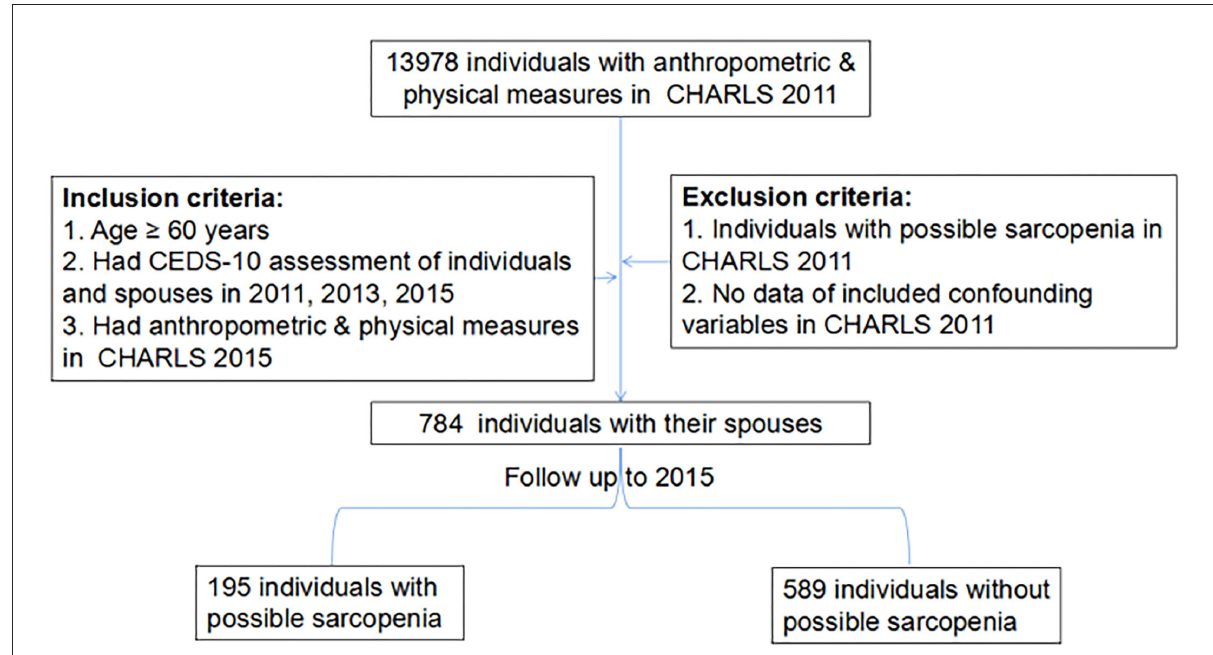
FIGURE1 Flow diagram of the study population. The study population was grouped according to whether individuals had possible sarcopenia in the China Health and Retirement Longitudinal Study